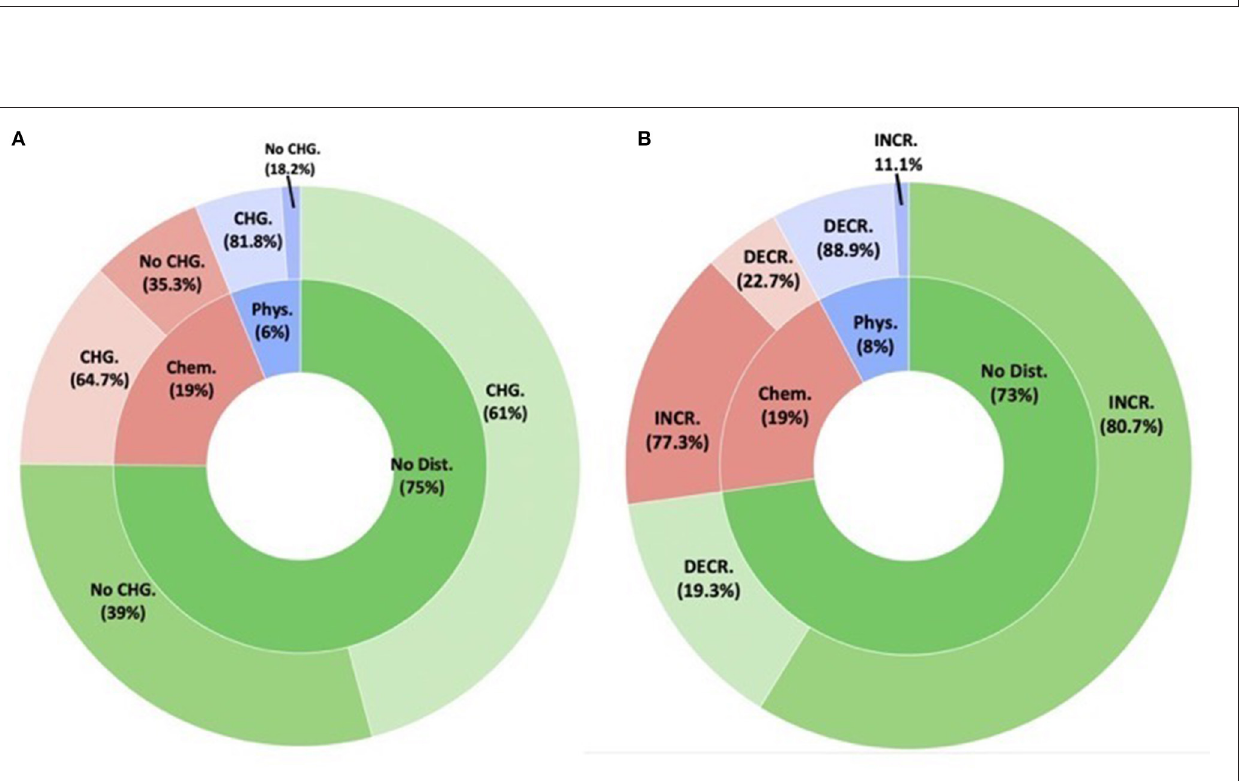
FIGURE 5 | The effect of inoculation on the resident bacterial communities in the presence of disturbance. (A) The inner ring demonstrates the disturbance type (physical disturbance, chemical disturbance, and no disturbance). The outer rings demonstrates the proportion of studies that showed bacterial community changes following inoculation. (B) Boxed pie chart demonstrates the directional community changes (increased vs. decline) per disturbance type for the studies that showed SMC changes following inoculation.